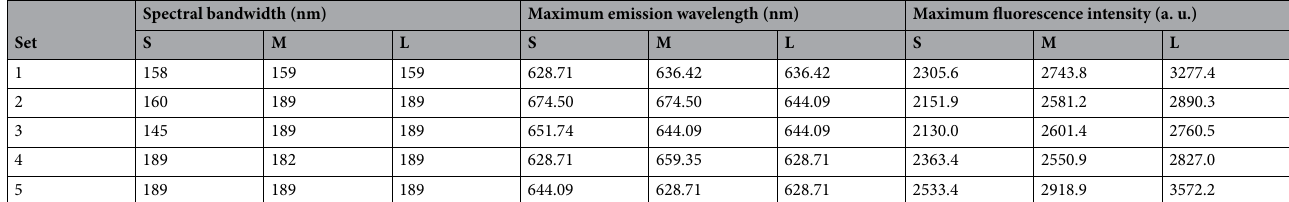
Table 2. Spectral parameters obtained of each set of in-vivo fluorescence spectra as shown in Fig. 2, when processing in a script development in MATLAB R2014a (The MathWorks, Inc.) software. Note that the values of the spectral bandwidth, maximum emission wavelength and maximum intensity are grouped by each set of cochineals, classified by the sizes presented in this study as S, M and L.